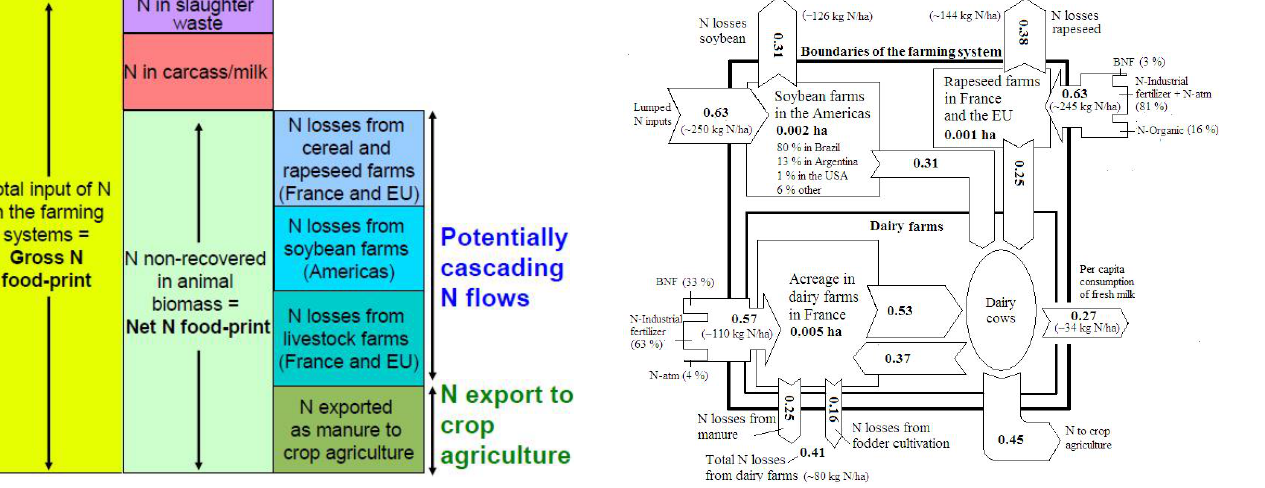
Fig. 6. Nitrogen and land requirements associated with the pro- duction of fresh milk. Arrows (bold type) refer to per capita N flows (kgNcapyr − 1 ) and rectangles to per capita land requirements (hacap − 1 yr − 1 ) per country of feed production. N input and output per hectare are given in brackets (kgNha − 1 ).